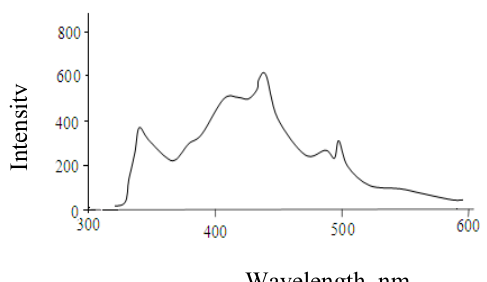
Figure 3 . PL spectra of PbO